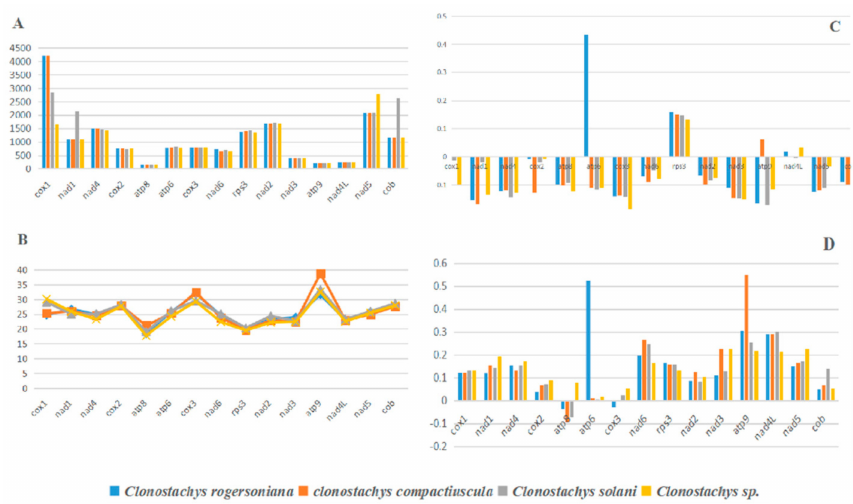
Figure 6. Variation in length and base composition of each of the 15 core protein-coding genes (PCGs) among four Clonostachys mitochondrial genomes. (( A ), PCG length variation; ( B ), GC content across PCGs; ( C ), GC skew; ( D ), AT skew).